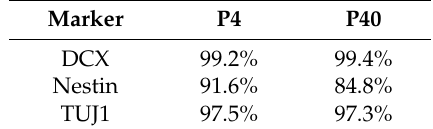
Table 3. Flow Cytometry results following stage one.